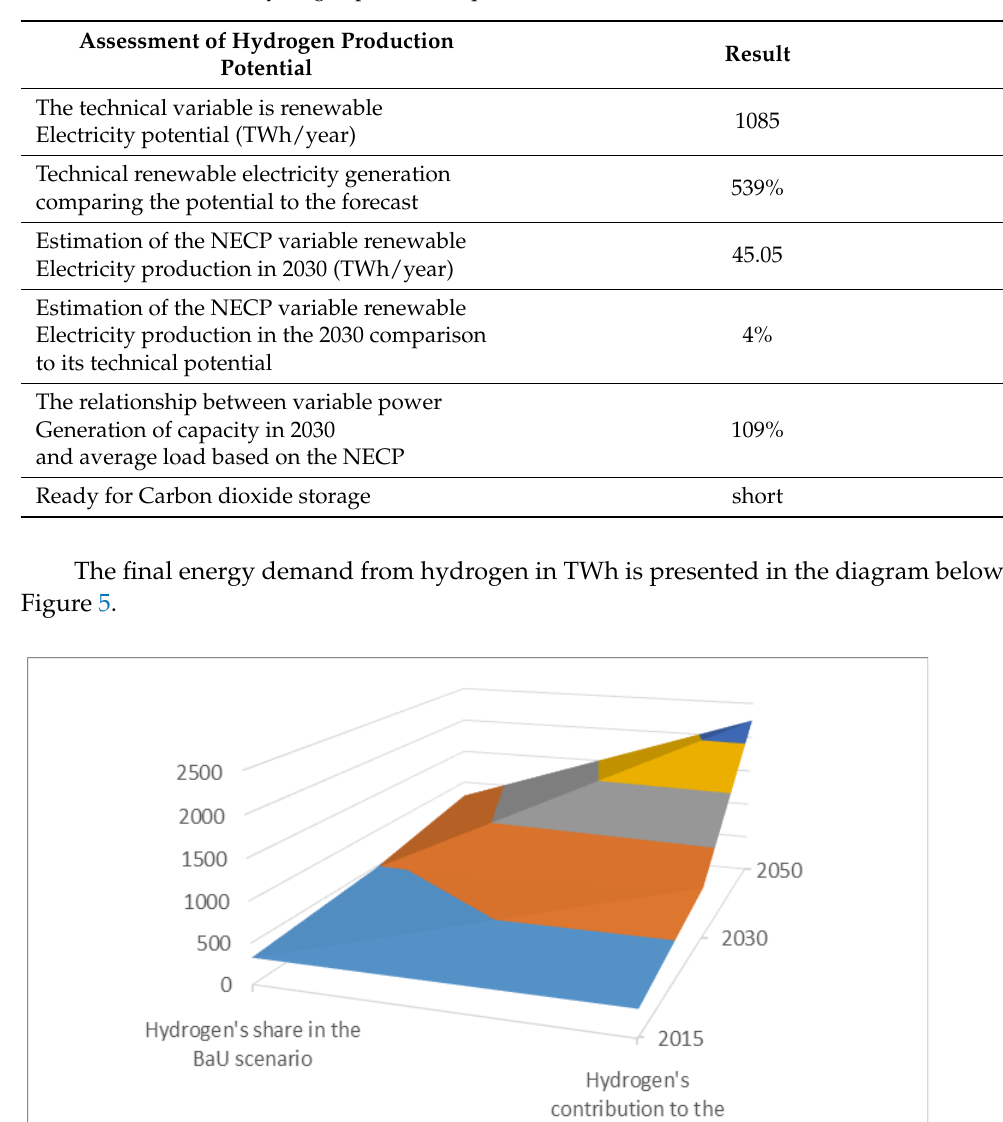
Table 1. Assessment of hydrogen production potential.